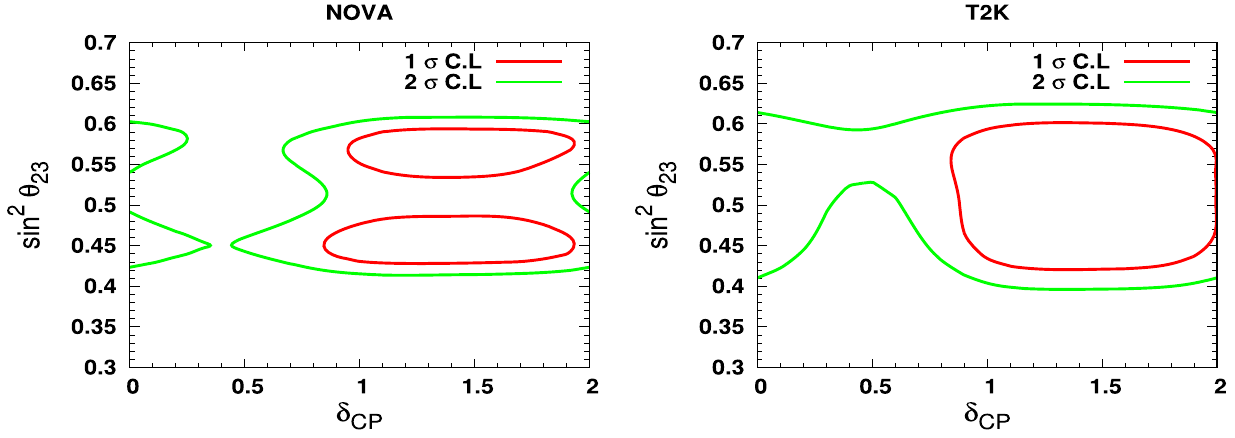
Fig. 5 Allowed 1 σ and 2 σ confidence regions for sin 2 θ 23 - δ CP parameter space obtained for NOvA (left) and T2K (right) experiments